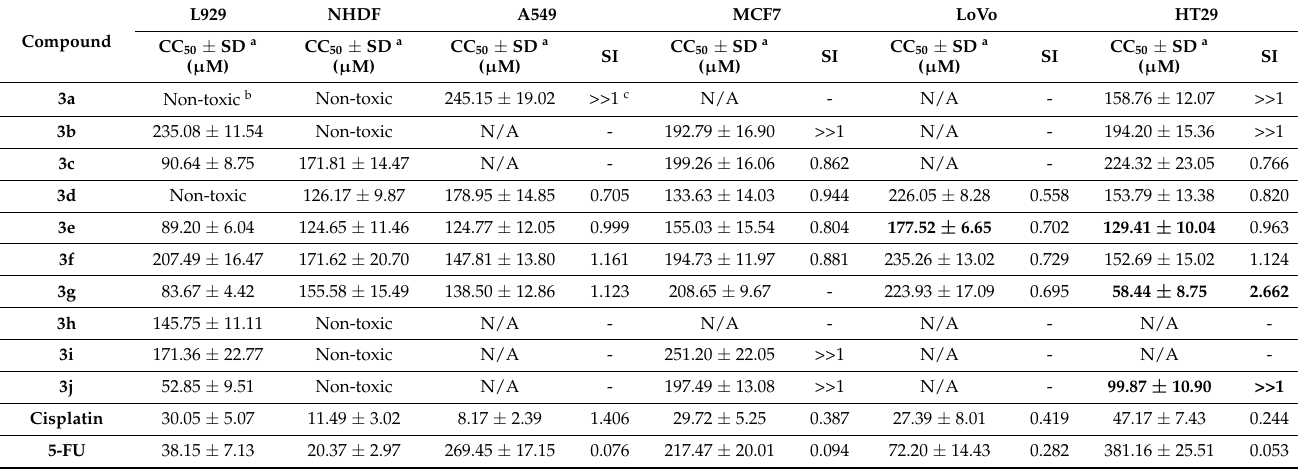
Table 1. Cytotoxic activity of compounds 3a–j and reference drugs against the tested cell lines determined in the MTT assay and expressed as the cytotoxic concentration ( CC 50 ± SD ) that causes a 50% reduction in viable cells. SD is the standard deviation. SI is the selectivity index, which is the ratio of the cytotoxic concentration ( CC 50 ) against healthy cells ( NHDFs ) to the cytotoxic concentration against cancer cells. N/A (i.e., not assessed) means that CC 50 could not be correctly determined in these